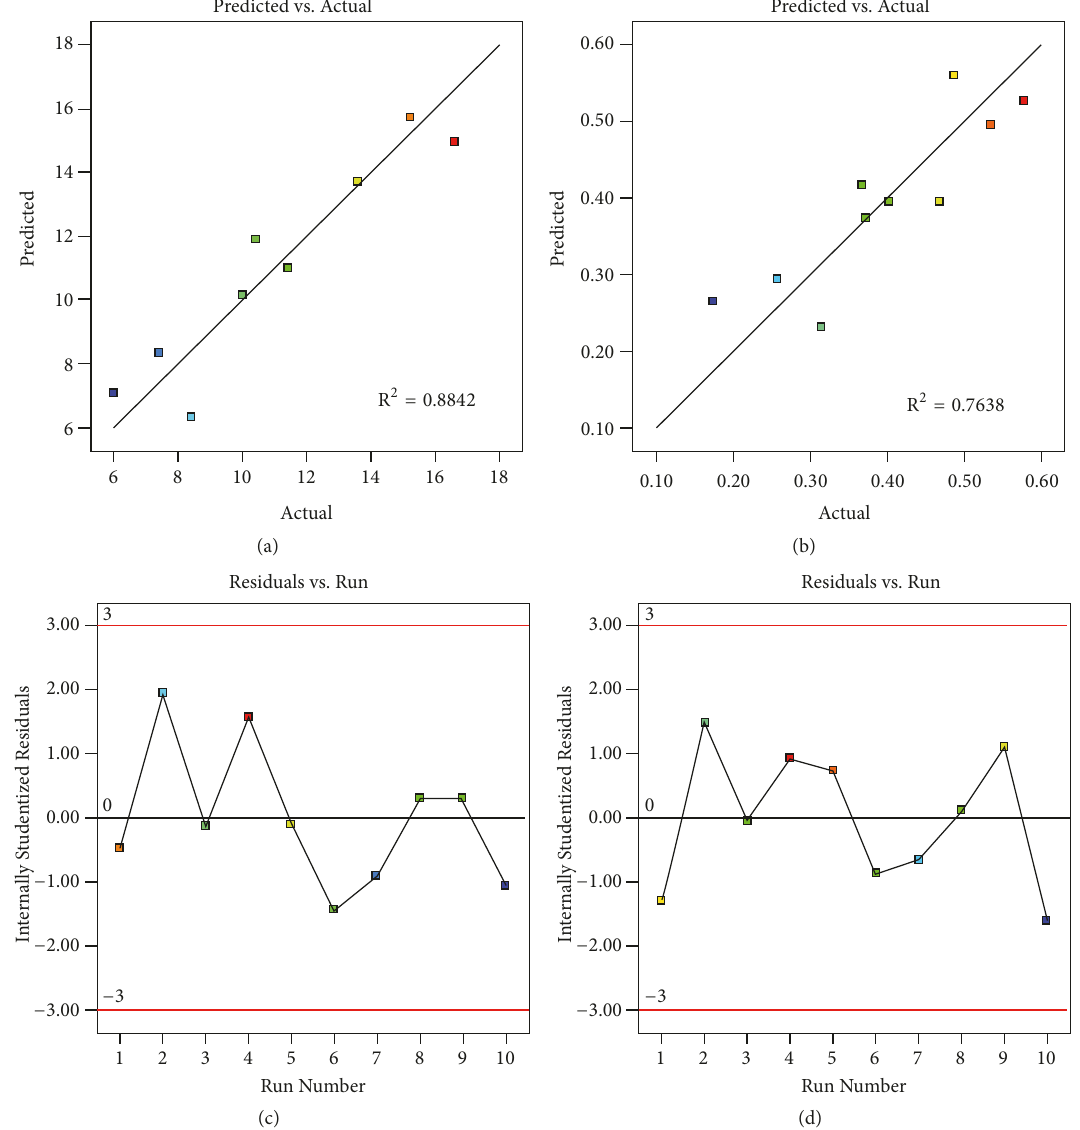
Figure 4: Predicted vs. actual value plots of model conditions of (a) yield of the extraction and (b) nitrate content and residuals vs. run plots of model conditions of (c) yield of the extraction and (d) nitrate